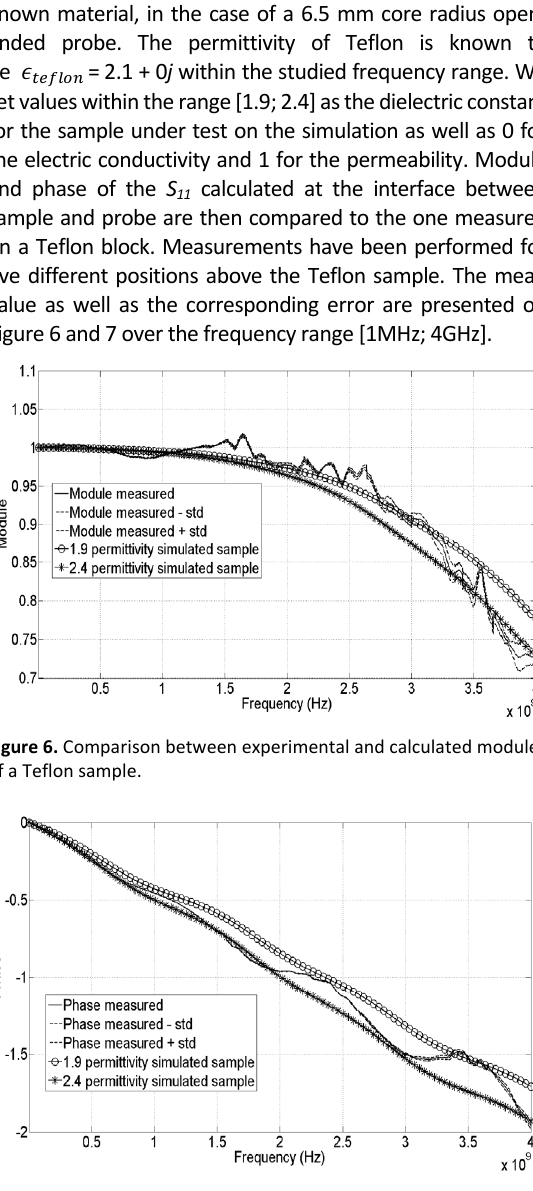
Figure 7. Comparison between experimental and calculated phases of a Teflon